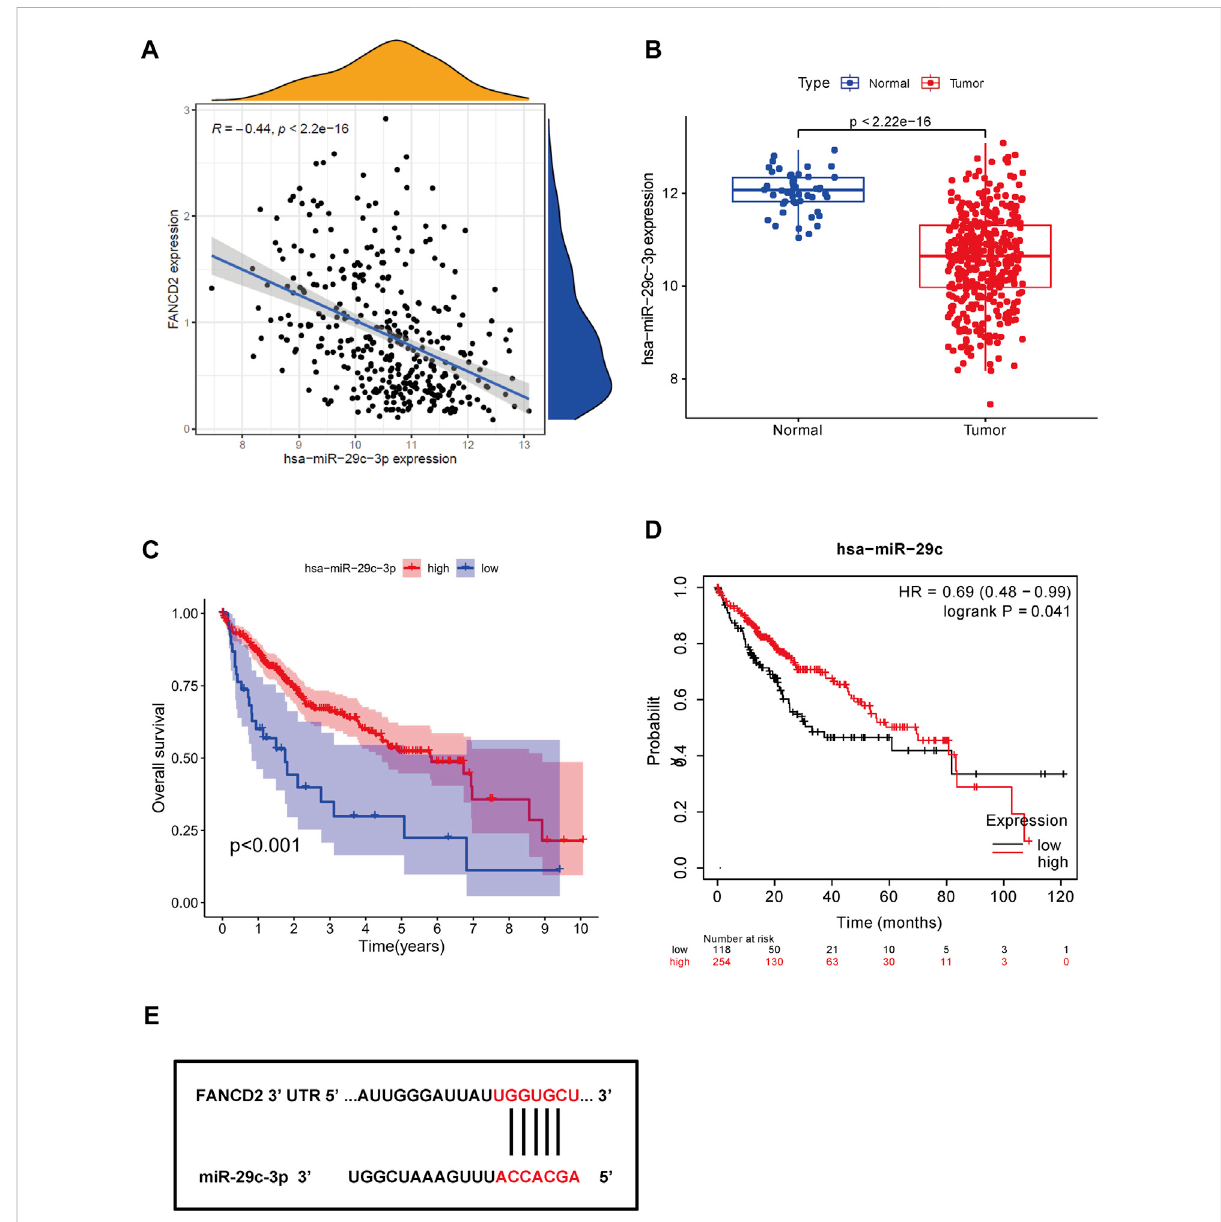
FIGURE 6 Identi fi cation of miR-29c-3p as the most potential regulatory miRNA of FANCD2 in HCC. (A) Association between FANCD2 and miR-29c-3p expression is shown in the dot plot. (B) Expression distribution of miR-29c-3p in HCC. (C,D) Kaplan ‒ Meier survival analysis of miR-29c-3p. (F) Base pairing of miR-29c-3p of the 3 ′ UTR in FANCD2-binding